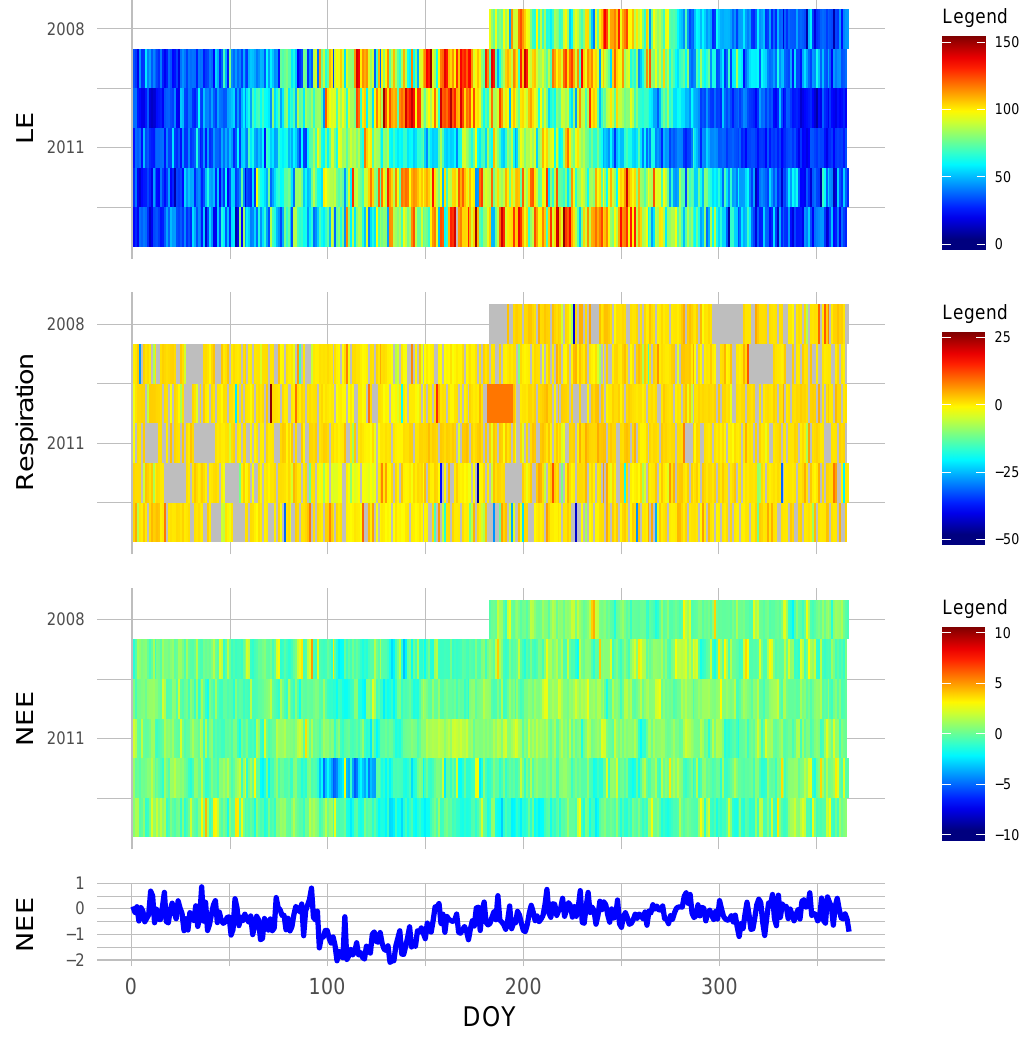
Figure A3. JERC-RD tower daily